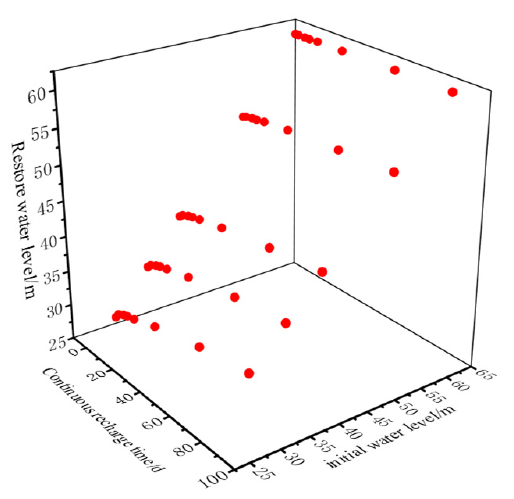
Figure 11. Restoration of water level at 1 d.